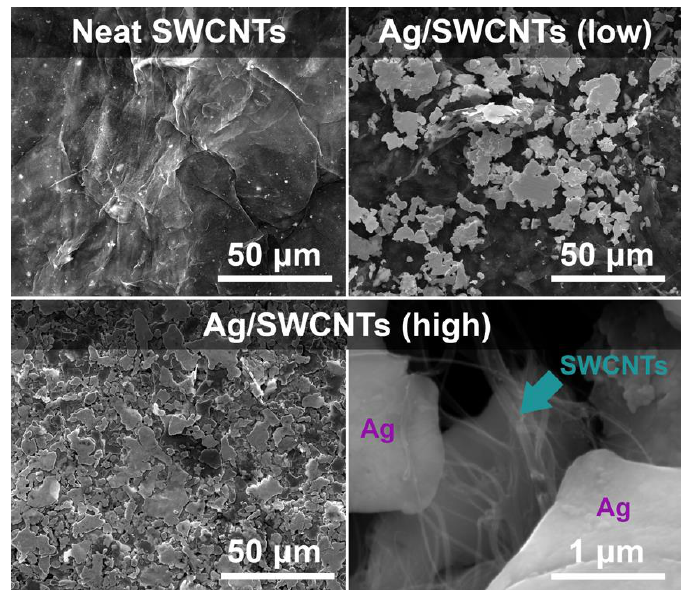
Figure 3. SEM micrographs of neat SWCNT films and upon doping with low (ten-fold dilution of the Ag conductive paint) and high amount of Ag (no dilution of the conductive paint).